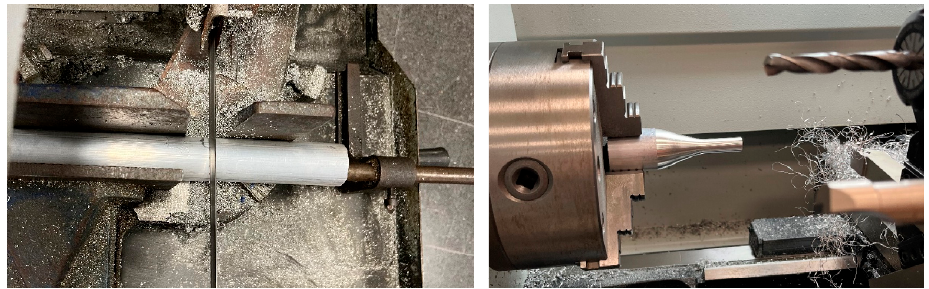
Figure 5. Cutting of the billet and external shaping of the mouthpieces on a Pinacho ST 225 × 1000 CNC lathe.